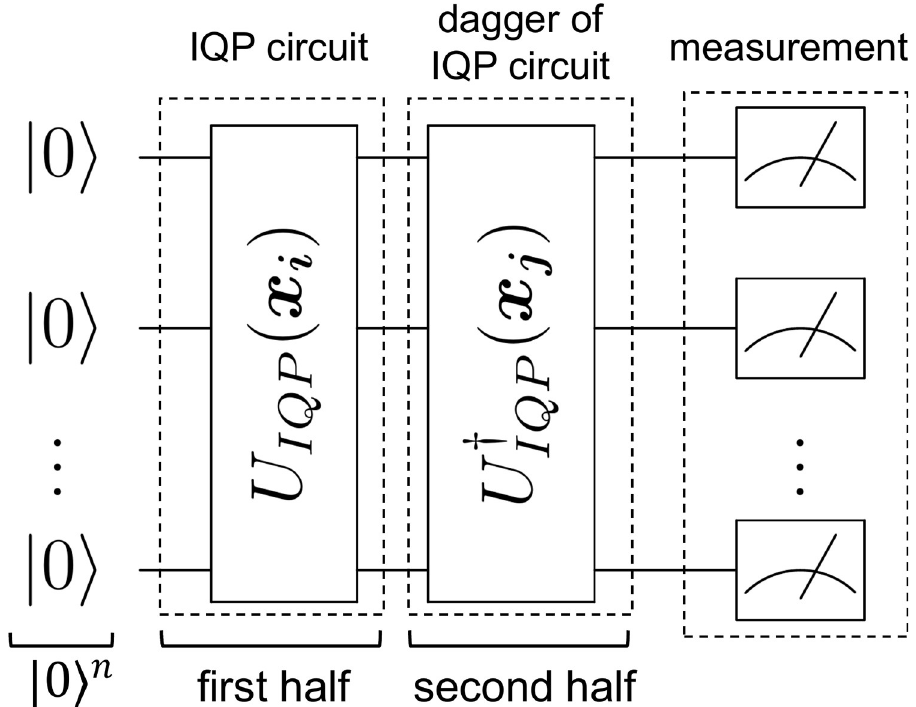
Fig 3. Inversion test. The circuit is divided into the first half and the second half, and the dagger of the first half is taken. U ( x ) represents Eq (8), which consists of layers with Hadamard gates H � n and a polynomial number of IQP diagonal matrices V ( x D